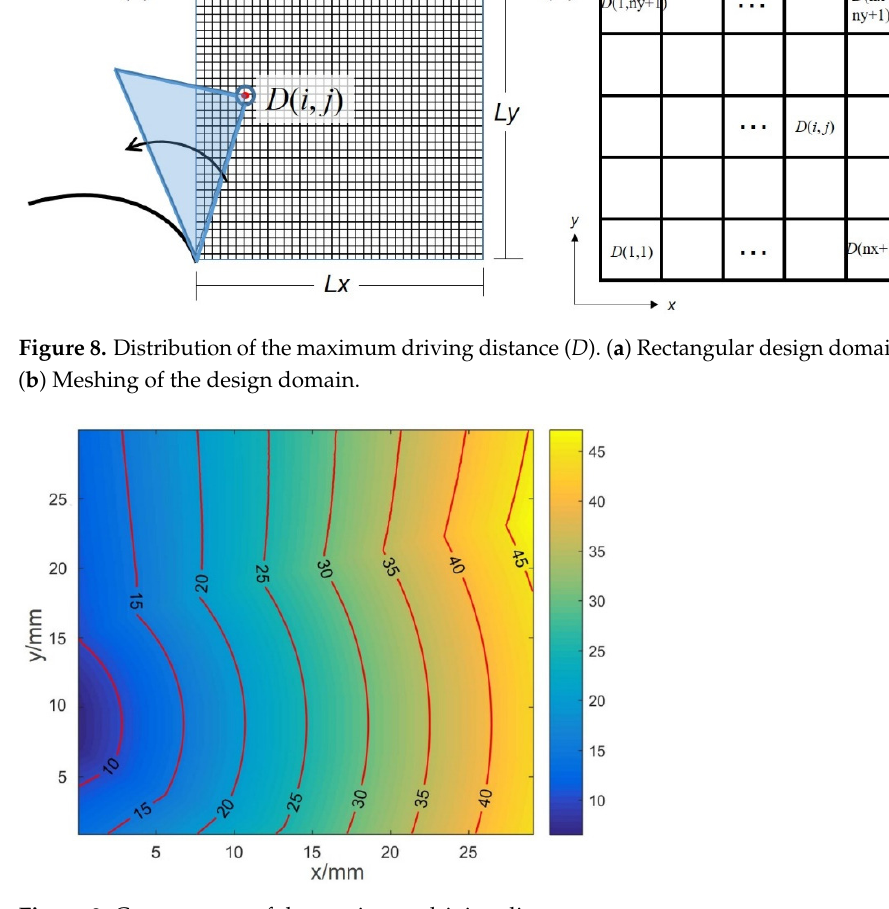
Figure 9. Contour map of the maximum driving distance.